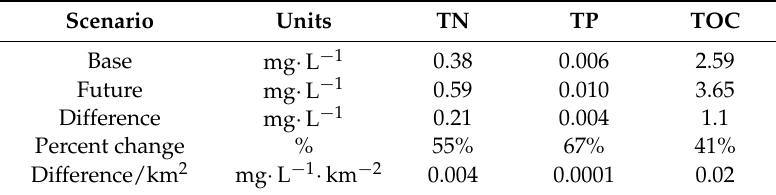
Median total nitrogen (TN), total phosphorus (TP) and total organic carbon (TOC) concentrations using daily simulated data at the drinking water intake on Converse Reservoir, AL, 1992 to 2005 ( n = 4292